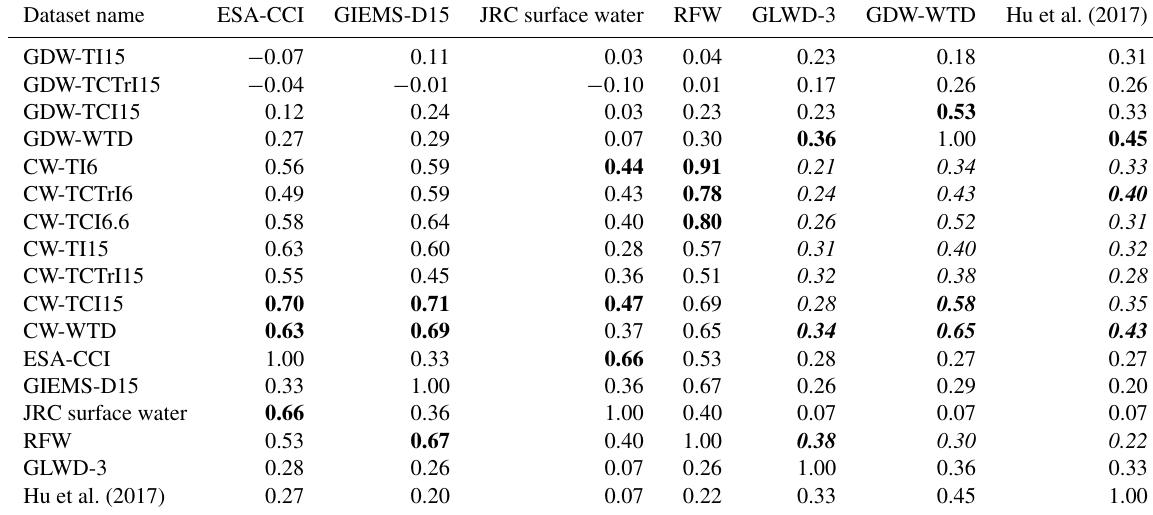
Table 5. Correlation between the developed and reference datasets (wetland fractions in 3arcmin grid cells). The highest three values in each column are shown in bold format, and values used in Fig. 4 are highlighted in italic